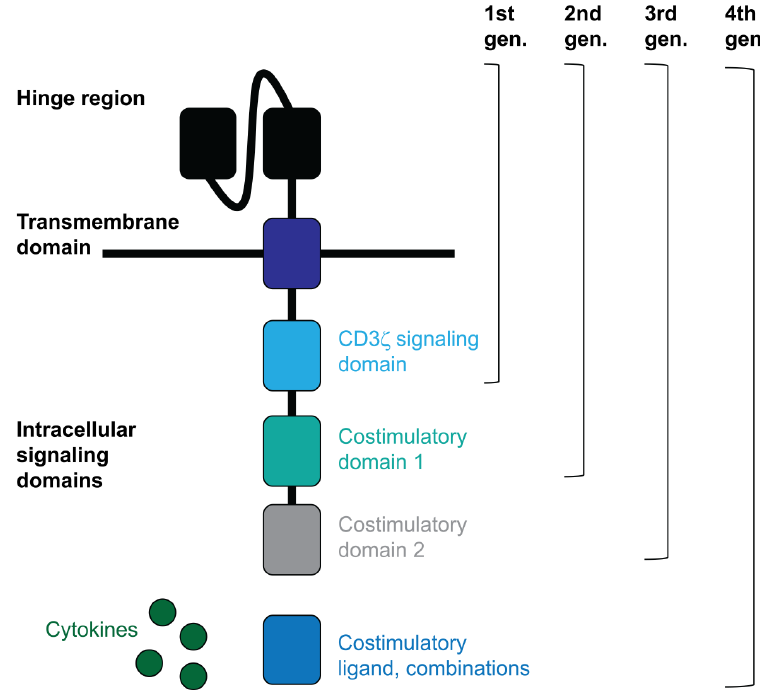
Figure 1. CAR structure. Figure 1. CAR CAR-T cell therapies are demonstrating elevated success rates for the treatment of haematological neoplasms [34]. Thus, the only CAR-T cell therapies approved for clinical practice by regulatory agencies are anti-CD19 CAR-T cells for CD19+ B-cell lymphopro- liferative malignancies (tisagenlecleucel (Kymriah™), Axicabtagene ciloleucel (Yes- carta™), Brexucabtagene autoleucel (Tecartus™), Lisocabtagene maraleucel (Breyanzi™), and anti-BCMA CAR-T cells for multiple myelomas (Idecabtagene vicleucel (Abecma ® ))